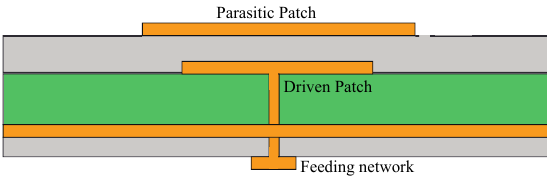
Figure 2. Example of parasitic patch antenna